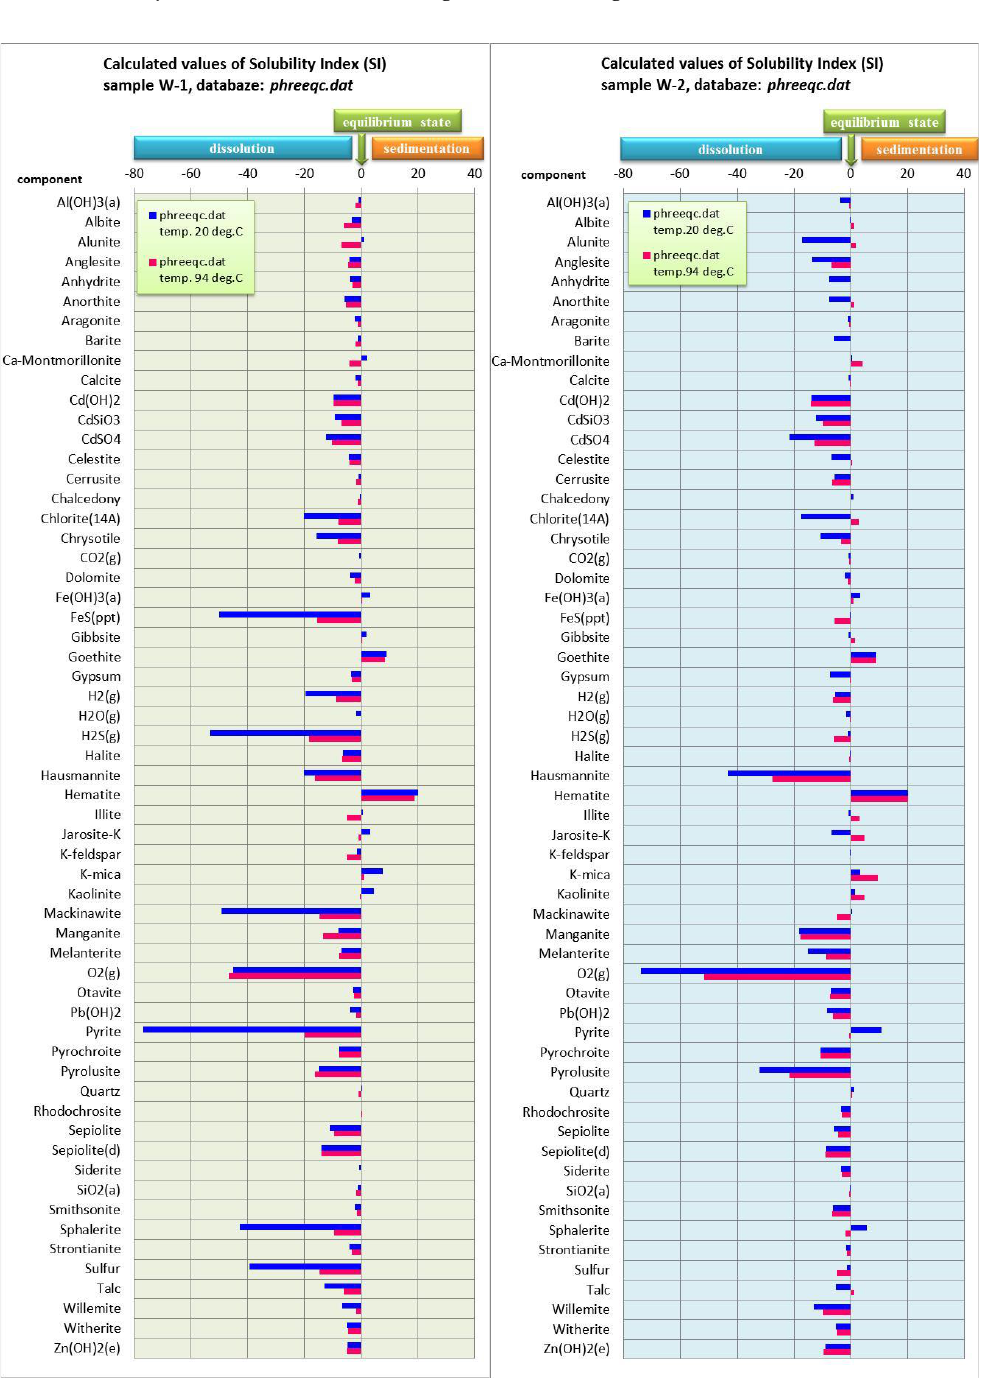
Figure 4. Comparison of SI calculated for W-1 and W-2 water samples using phreeqc.dat database at 20 °C (ambient) and 94 °C (deposit) temperatures.